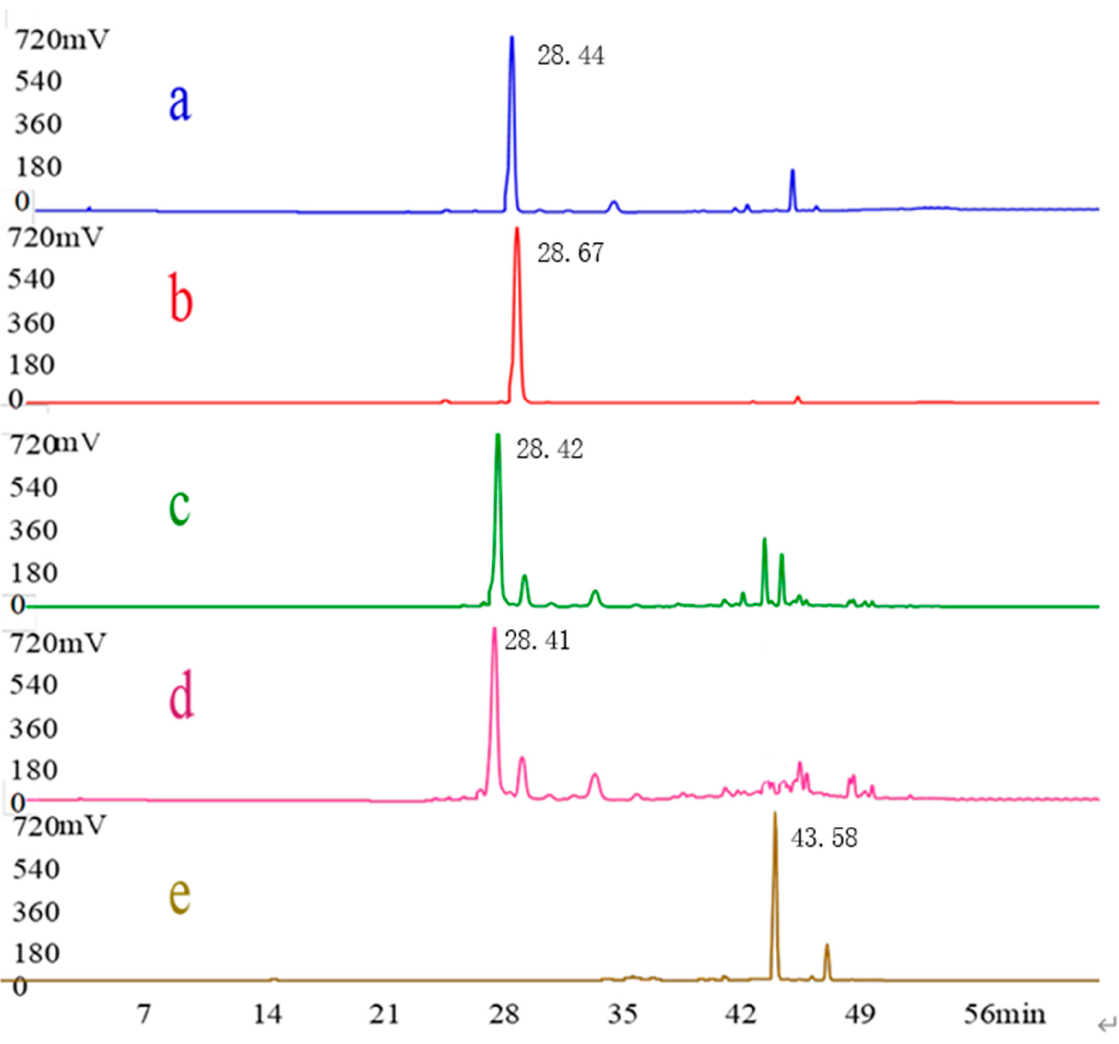
Figure 2. HPLC chromatograms. λ = 440 nm of the crude EGJ ( a ), the standard compound of crocin I ( b ), the No.8 sample ( c ), the No.9 sample ( d ), and the No.14 sample ( e ).